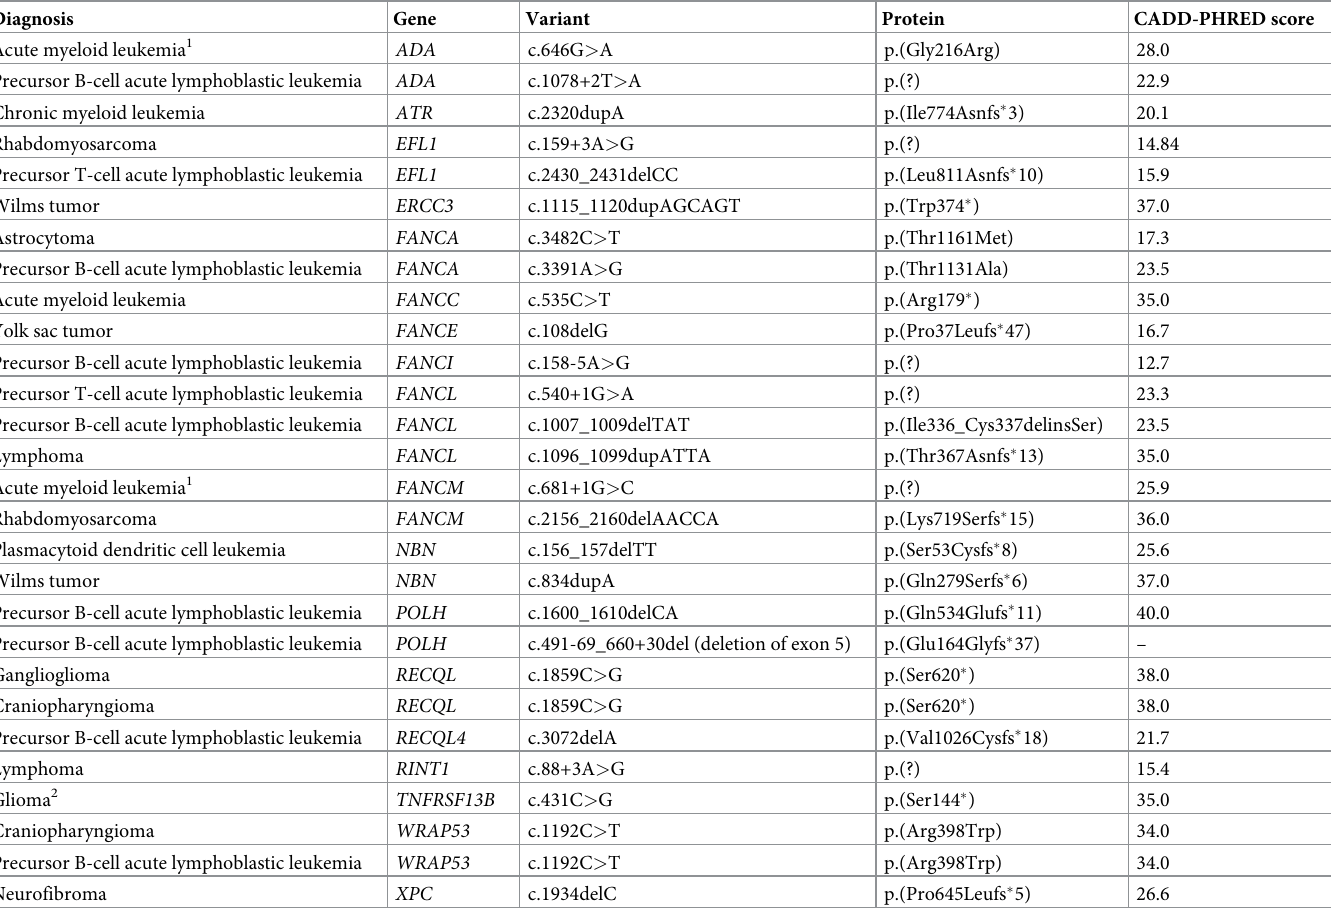
Table 6. Patients with pathogenic or likely pathogenic variants in biallelic cancer predisposition